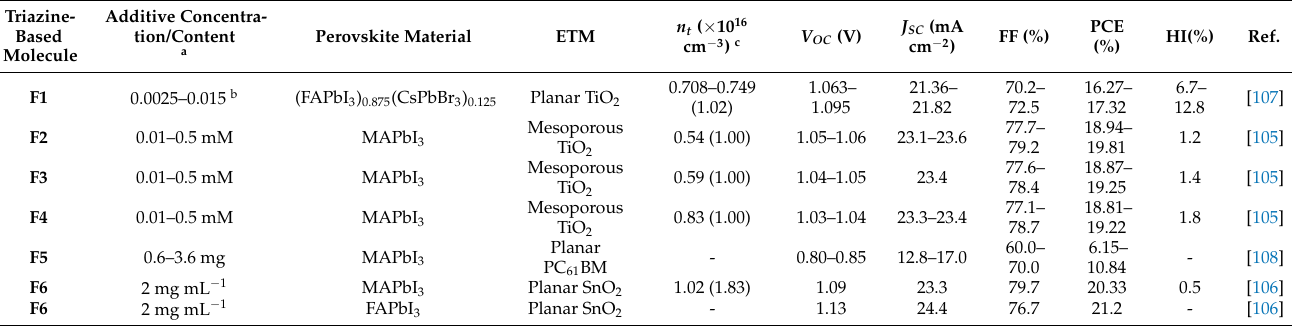
Table 6. Photovoltaic parameters of PSCs using triazine derivatives for surface passivation.